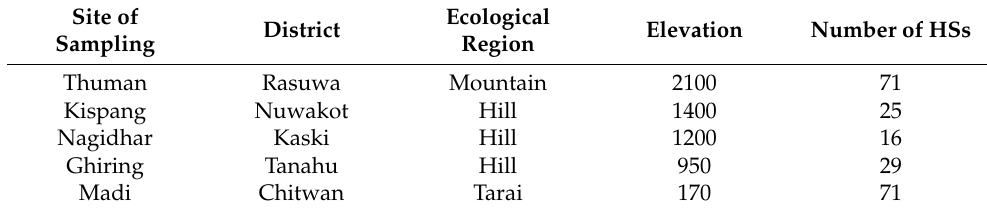
Figure 1. Distribution of sampled villages in the GRB, Nepal. Table 1. Details of the study sites in the Gandaki River Basin. Table 1. Details of the study sites in the Gandaki River